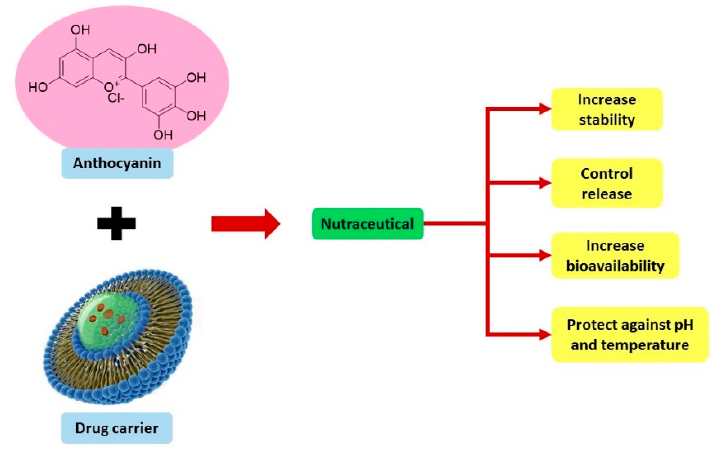
Figure 4. Advantage of anthocyanin in nutraceutical